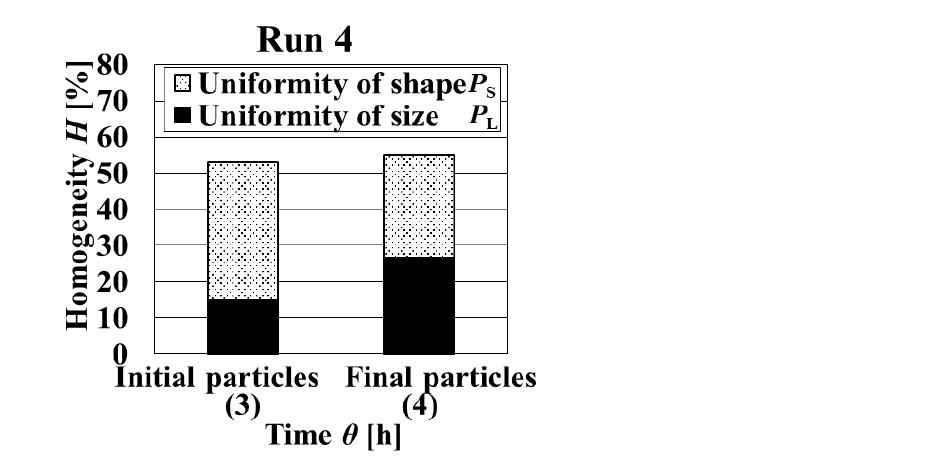
Figure 9. Dynamic variation in homogeneity and uniformity of the distributions of particle size and crystal shape with crystallization time in Run 4.